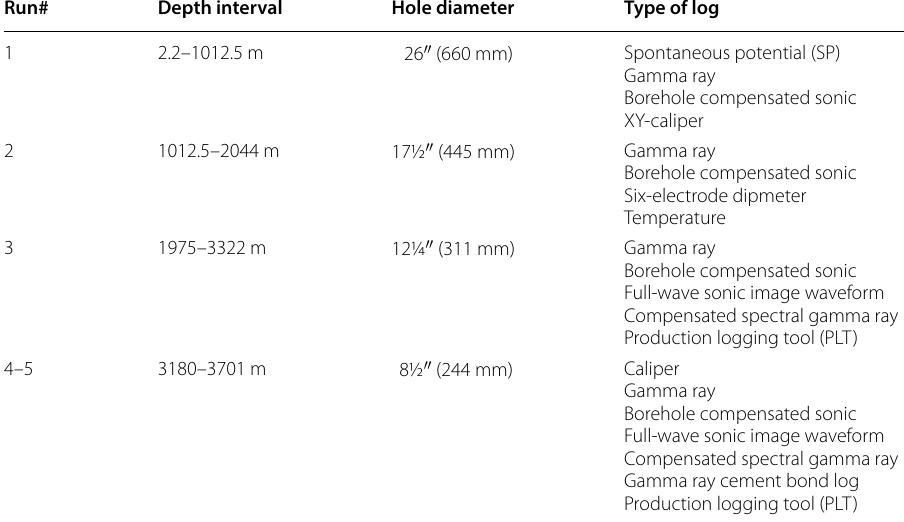
All logging runs were conducted in open hole